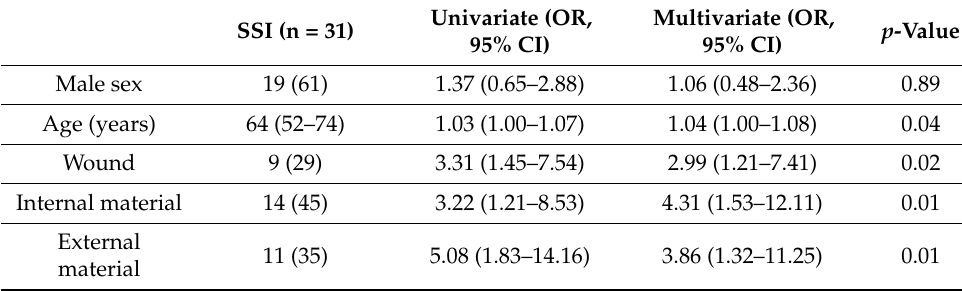
Table 4. Risk factors for surgical site infections among diabetic